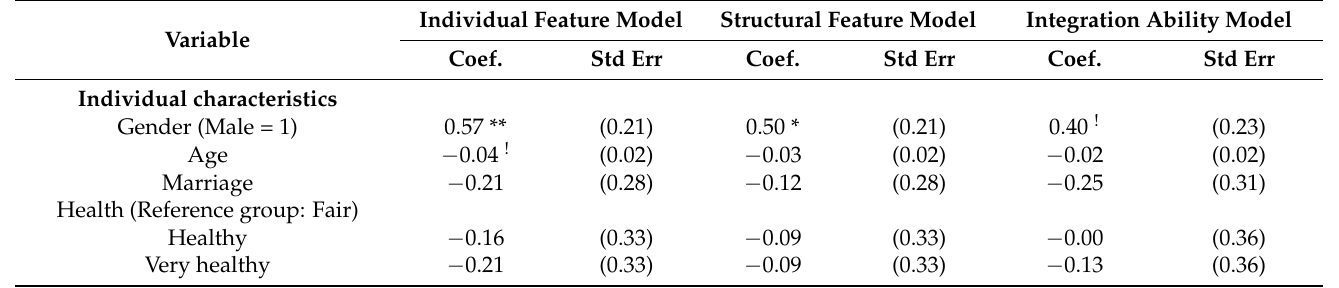
Table 3. Objective Social Integration Model. (O-Logit Regression